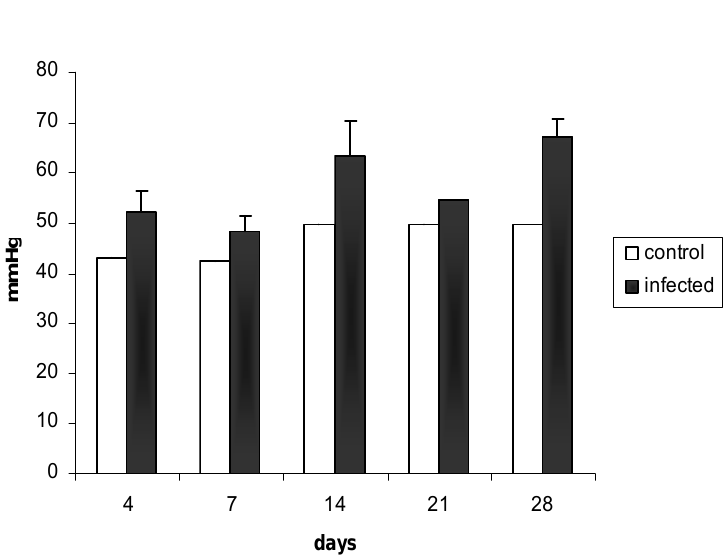
Figure 2. Mean arterial carbonic gas tension (PCO hamsters inoculated with Leptospira interrogans Icterohaemorrhagiae and their respective control